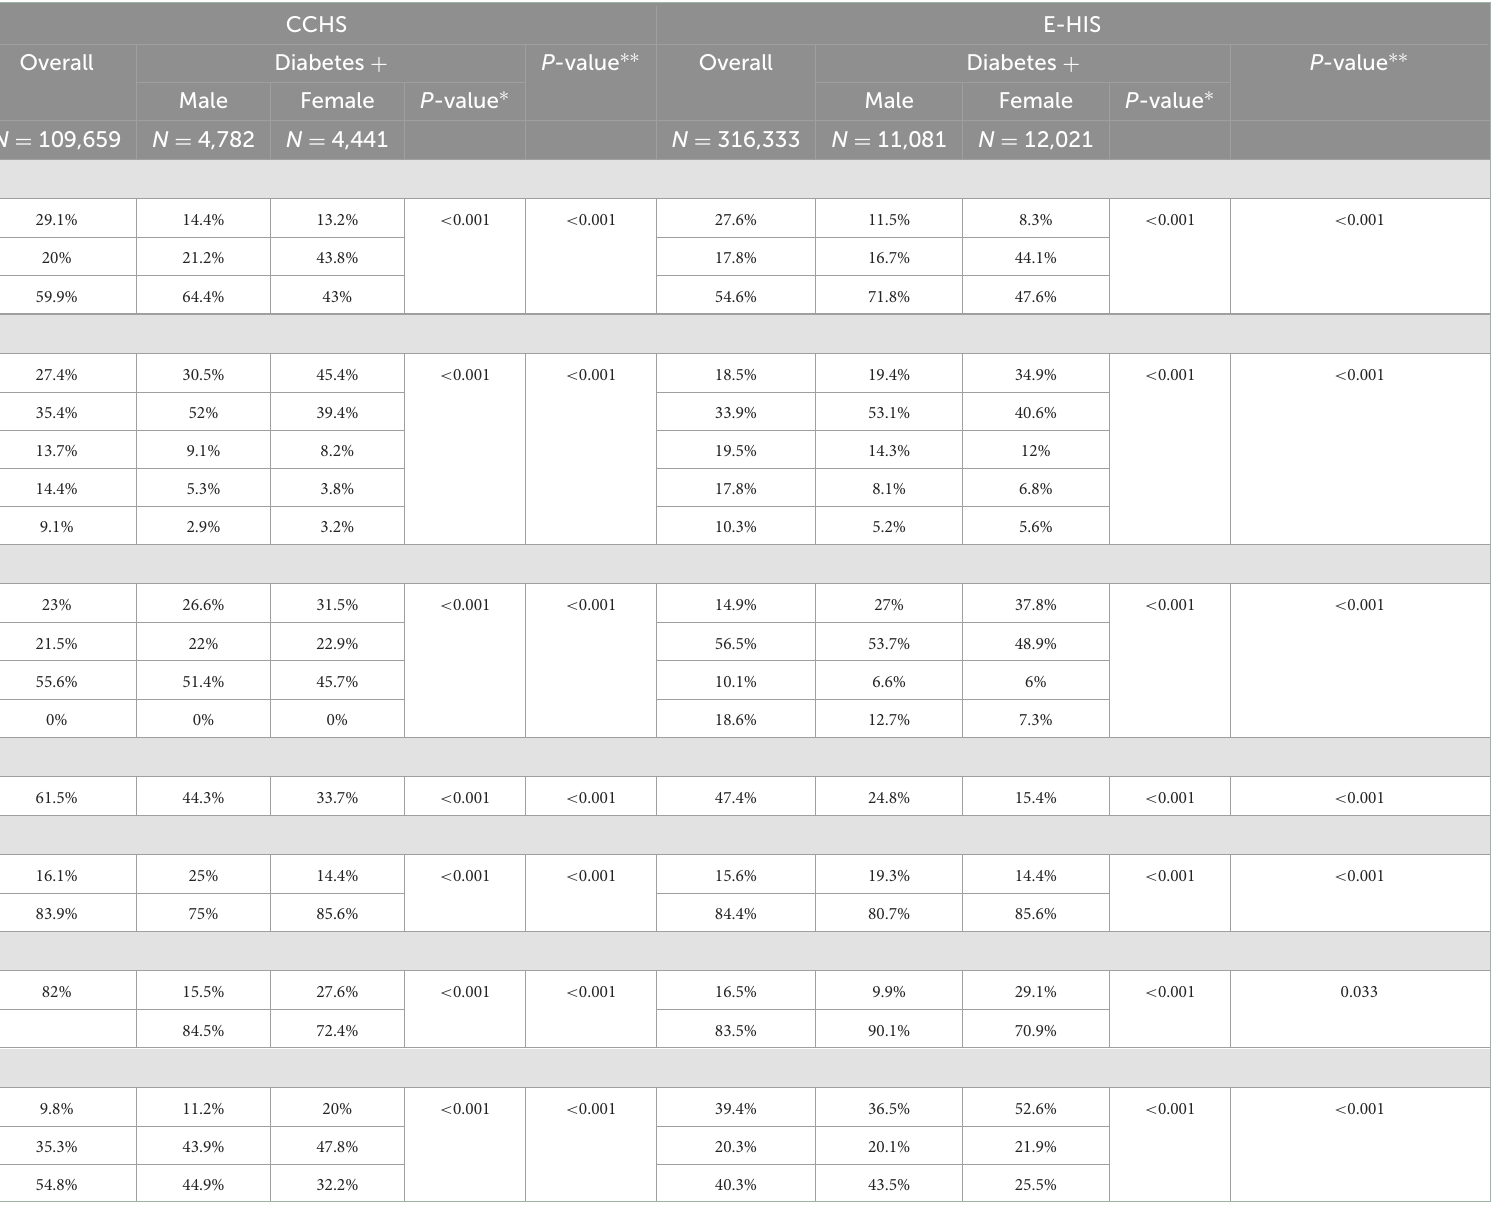
TABLE 1B Descriptive result of gender related variables in Canadian and European populations in the 2014–2016 surveys in overall and patients with